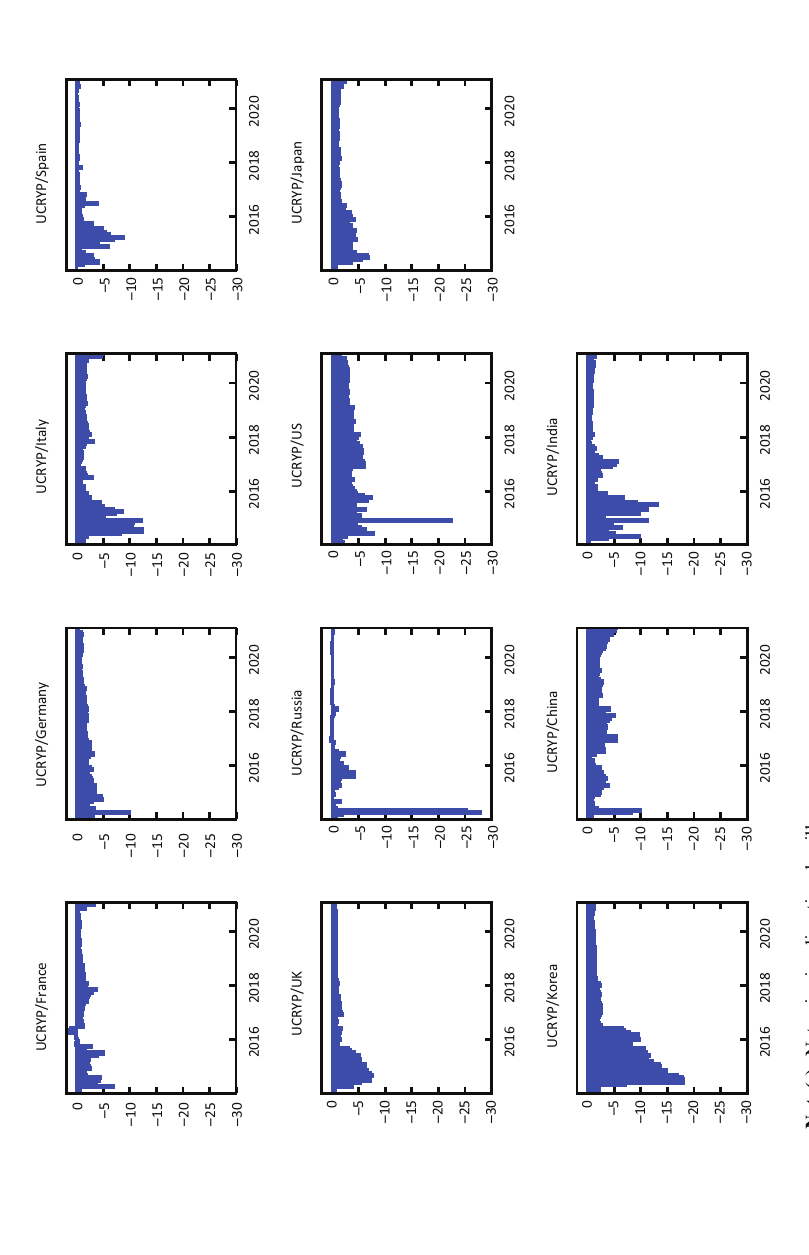
Figure 4. Net pairwise